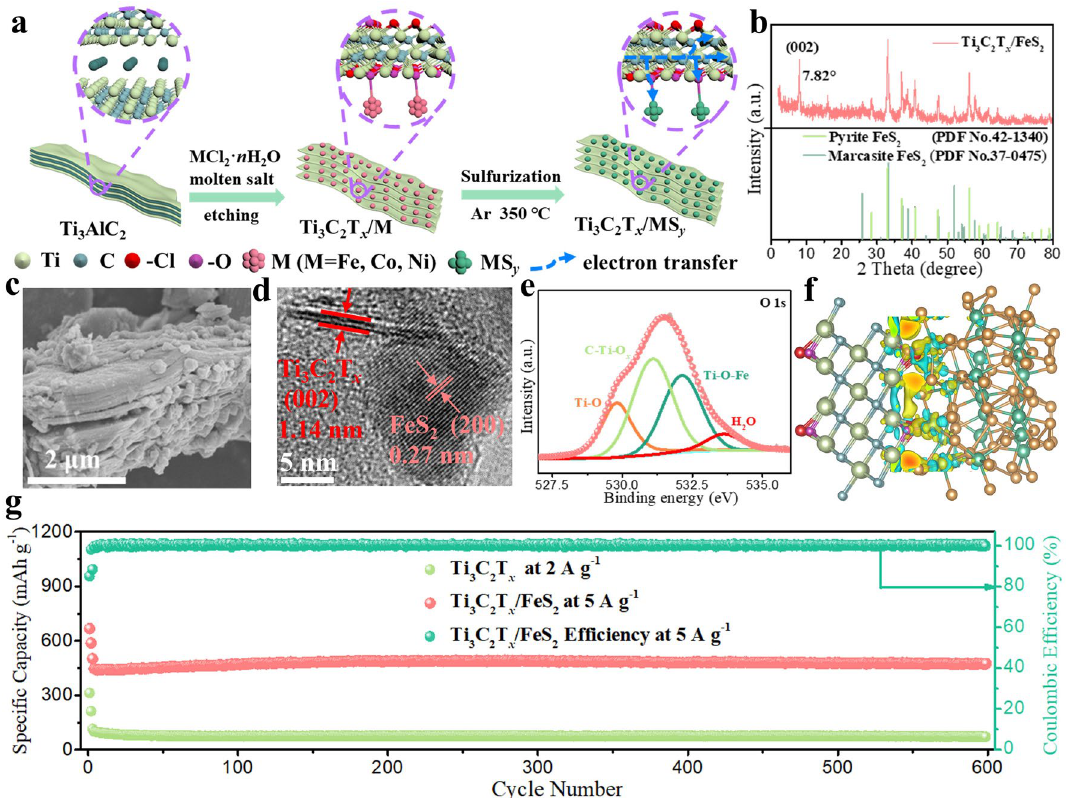
Fig. 11 a Schematic of the fabrication process of Ti 3 C 2 T x /MS y hybrids. b XRD pattern of Ti 3 C 2 T x /FeS 2 composites. c SEM image of Ti 3 C 2 T x / FeS 2 hybrids. d HRTEM image of Ti 3 C 2 T x /FeS 2 . e O 1 s XPS spectra of Ti 3 C 2 T x /FeS 2 . f Charge density difference of Ti 3 C 2 T x /FeS 2 composites. g Cyclic performance of Ti 3 C 2 T x MXene and Ti 3 C 2 T x /FeS 2 hybrids at various current densities. Reproduced with permission from [147] Copy- right 2022,